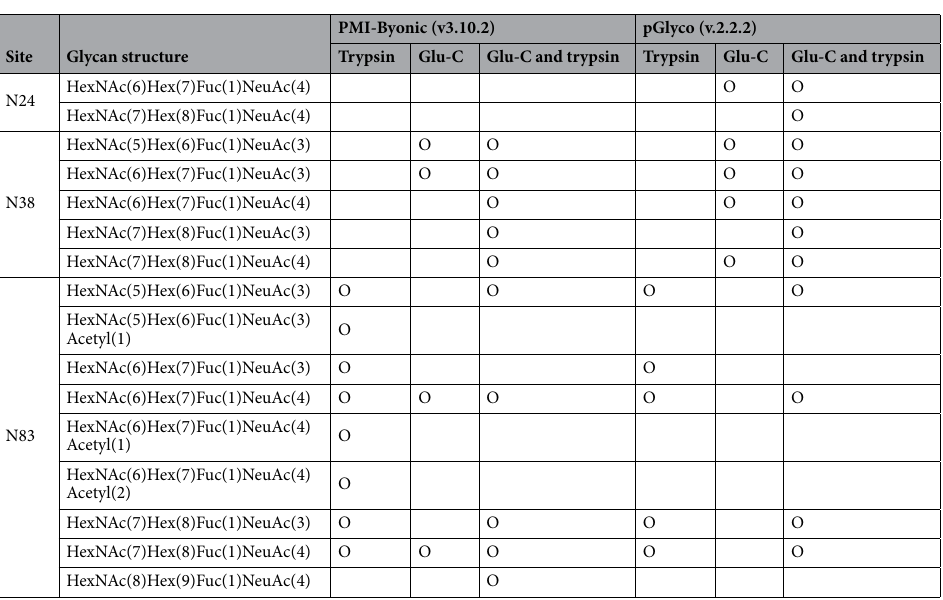
Table 1. Results of glycan profiling through a comparison of three enzymes. HexNAc, N-acetylhexosamine; Hex, Hexose; Fuc, Fucose; NeuAc, Sialic acid.